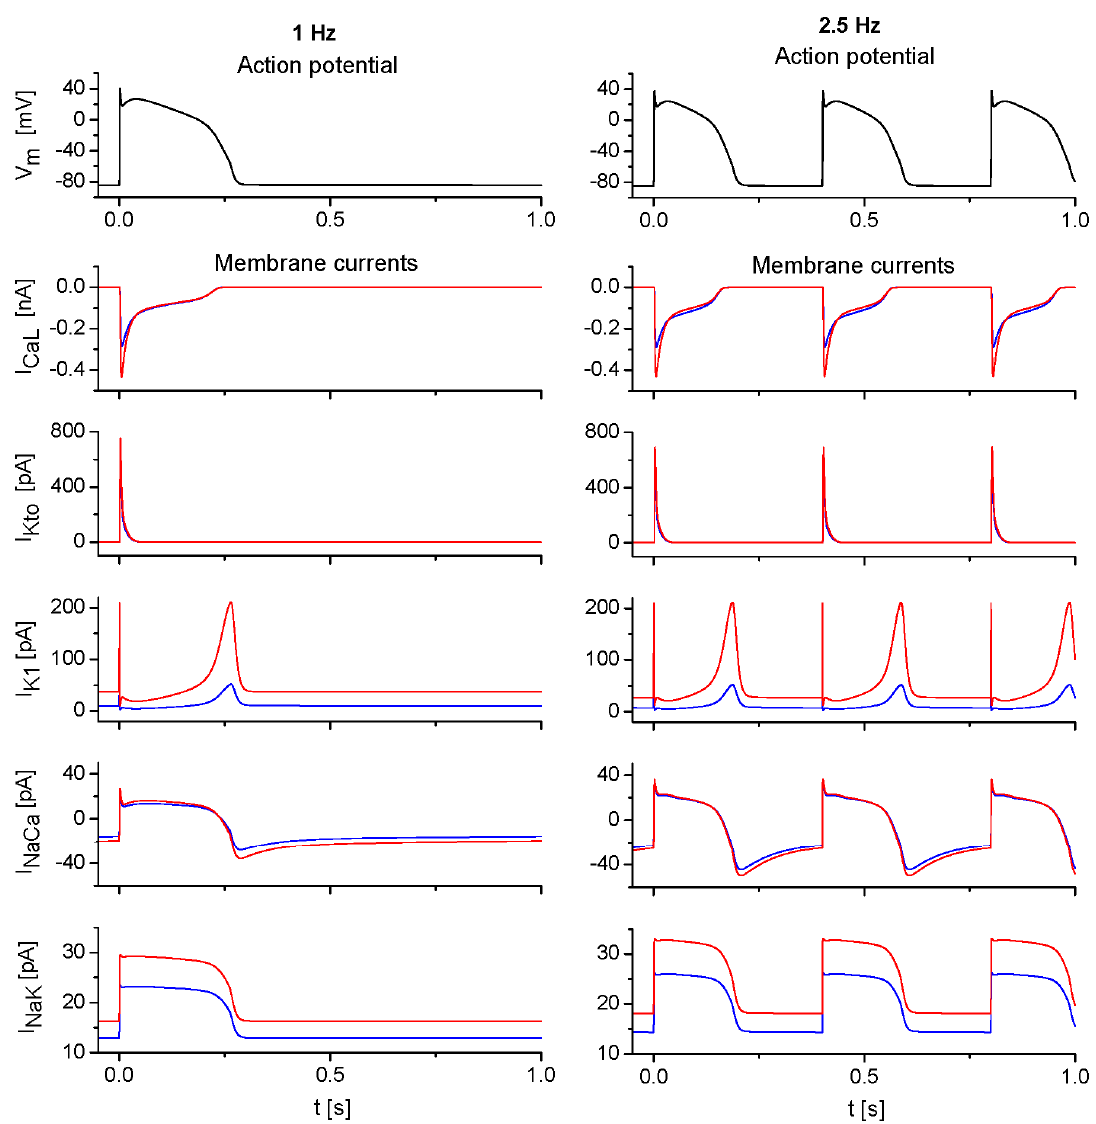
Figure 1. Action potentials ( V at steady-state under 1 Hz ( left panel ) and 2.5 Hz ( right panel ) stimulation. Blue and red continuous lines refer to surface and t-tubular membrane,